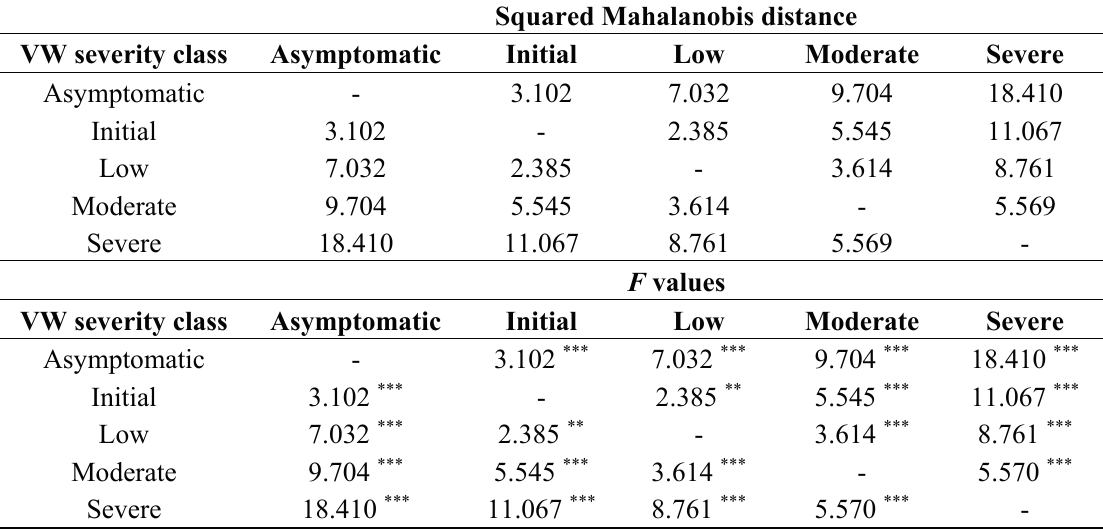
Table 6. Squared Mahalanobis distances for Verticillium wilt severity classes obtained in a forward stepwise discriminant